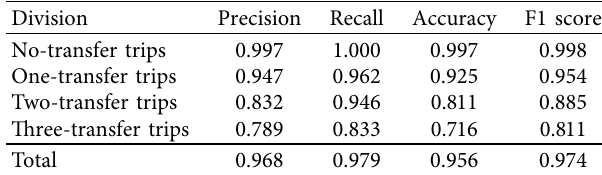
Table 5: Result of travel route estimation with private subway